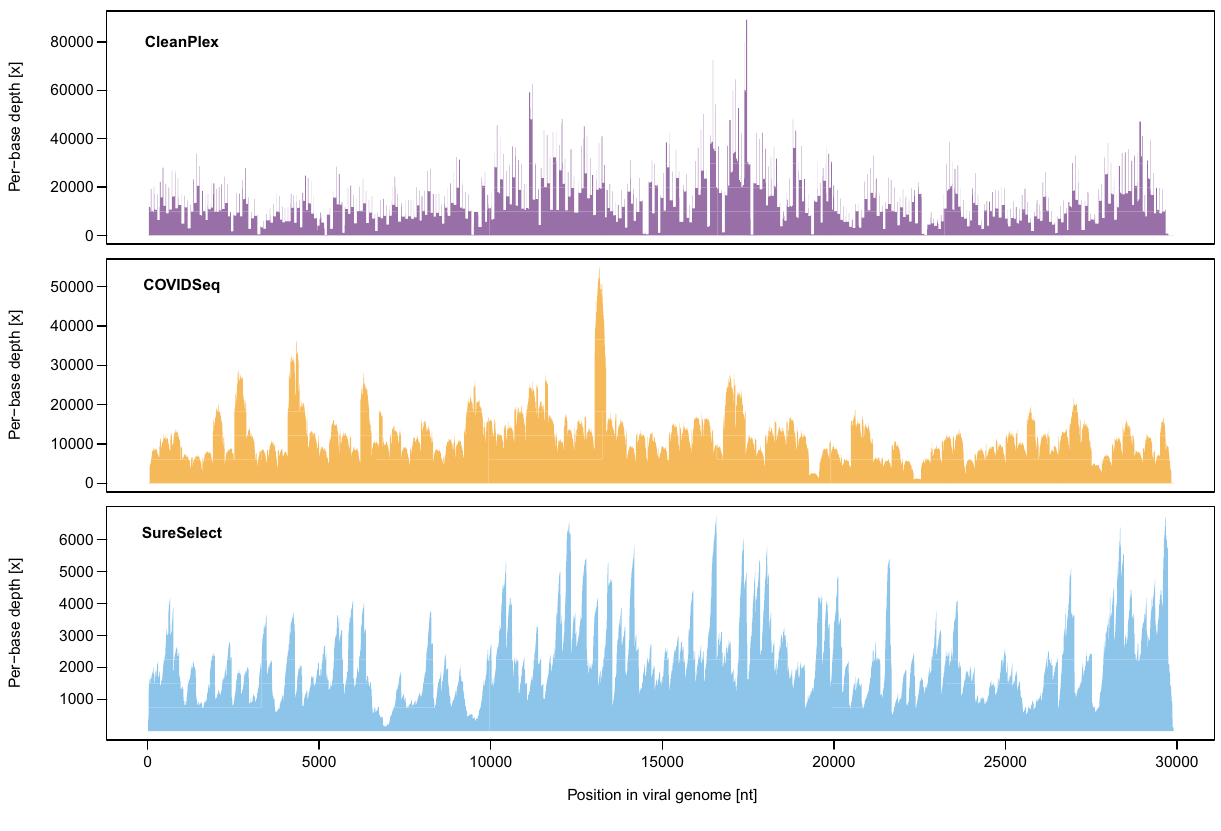
Figure 2. Depth of coverage profile of a typical library constructed with different kits.